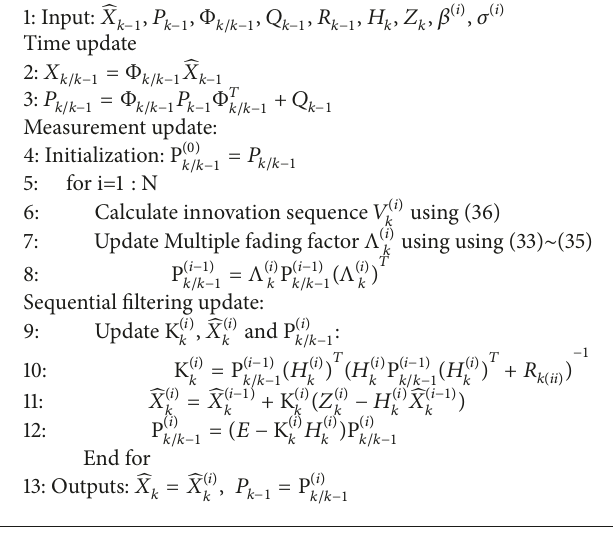
Algorithm 1: Multiple fading factor strong tracking sequential Kalman filter.